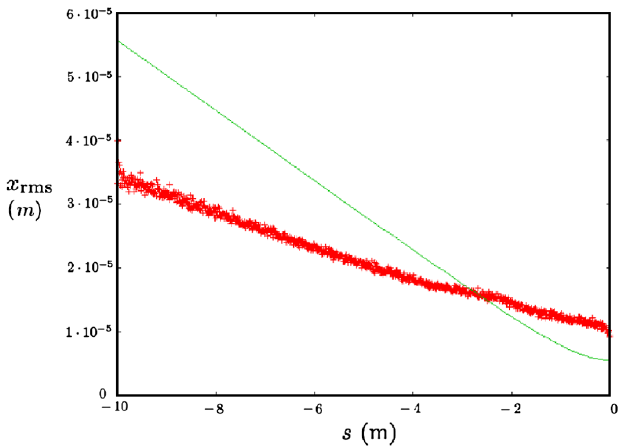
FIG. 5. (Color) Ion transverse density profile at s (cid:5) (cid:10) 1 m in the 20 m beam model and comparison with a 1 =r distribution.FIG. 4. (Color) Beam (solid line) and ion ( (cid:8) ) transverse stan-